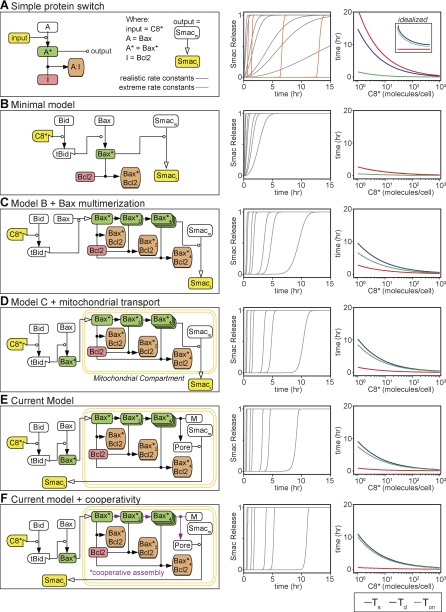
Role of Network Topology in Generating Snap-Action BehaviorModels representing varying topologies of the MOMP module were analyzed for snap-action behavior. For each model, the input species (C8*) was introduced at values ranging from 1 to 103 molecules/cell, and the resulting release behavior of Smac determined by simulation (middle column). The kinetic characteristics Ts, Td, and Ton (defined as the time at which Smac release reached 1% of its final value) for Smac release were determined from these simulations as a function of input strength (right column). Note that f = 1 in all cases and therefore Tc = Ts. Binding of Bid to Bcl-2 was omitted for simplicity, although this interaction is included in the full EARM v1.0.(A) Basic motif model. Simulations are shown for parameter sets representing physiologically realistic rate constants (gray) and for irreversible, faster-than-diffusion binding (orange) for Bax-Bcl-2 association, and Ts, Td, and Ton curves shown only for physiologically realistic values. The inset plot in the right column shows the expected behavior for an idealized variable-delay snap-action switch.(B) Model of known topology, including Bid cleavage.(C) Model including Bax oligomerization.(D) Model including separate mitochondrial reaction compartment.(E) Model corresponding to the MOMP module in EARM v1.0. Note that the cytosolic pool of Bcl-2 anti-apoptotic proteins, which binds to tBid in EARM v1.0, has been omitted for simplicity.(F) Model as in (F), but with rate constants for Bax oligomerization and insertion adjusted to represent positive cooperativity.